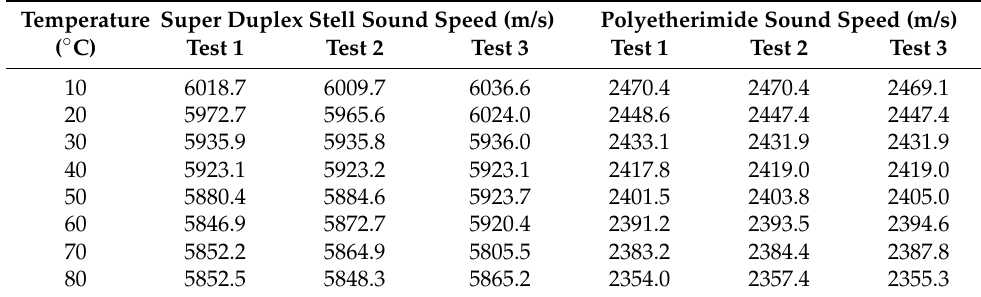
Table 1. Super duplex steel and polyetherimide sound speeds under different temperatures. Temperature Super Duplex Stell Sound Speed (m/s)